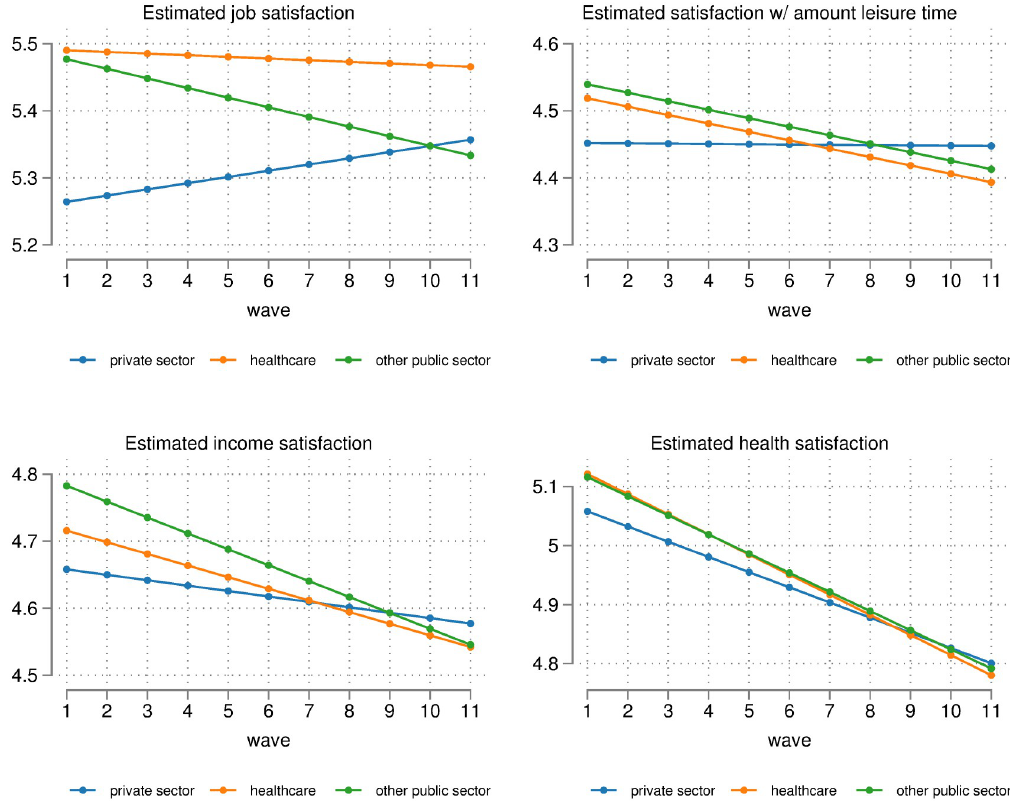
Fig 3. Difference in satisfaction levels of healthcare workers over time, relative to other public sector workers and non- public sector workers (plotted using FE regressions shown in Table 1).